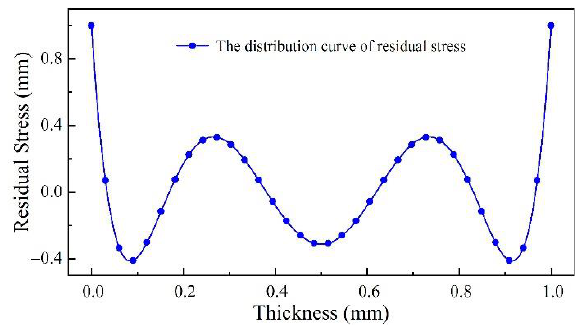
Figure 4. Initial residual stress model.